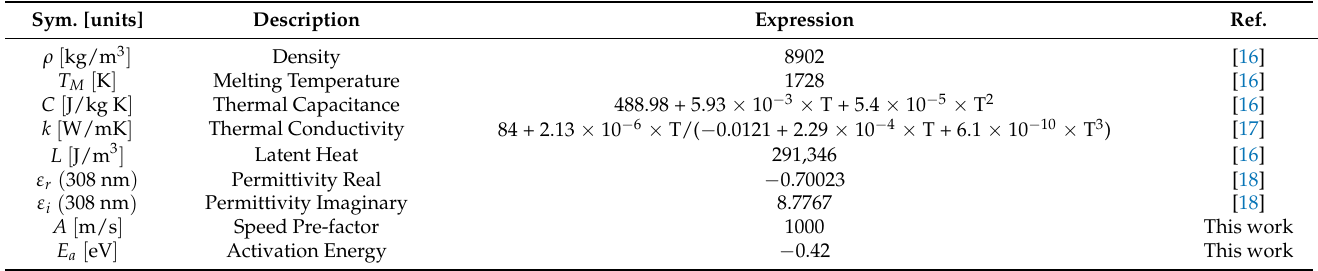
Table 1. Ni crystal material calibration